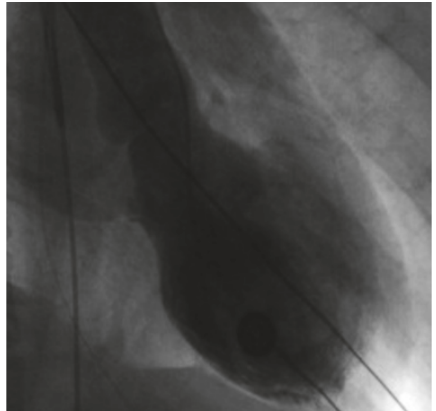
Figure 3: Left ventriculogram during end-systole phase, demonstrating basal segment contraction and anterolateral/apical hypokinesia.